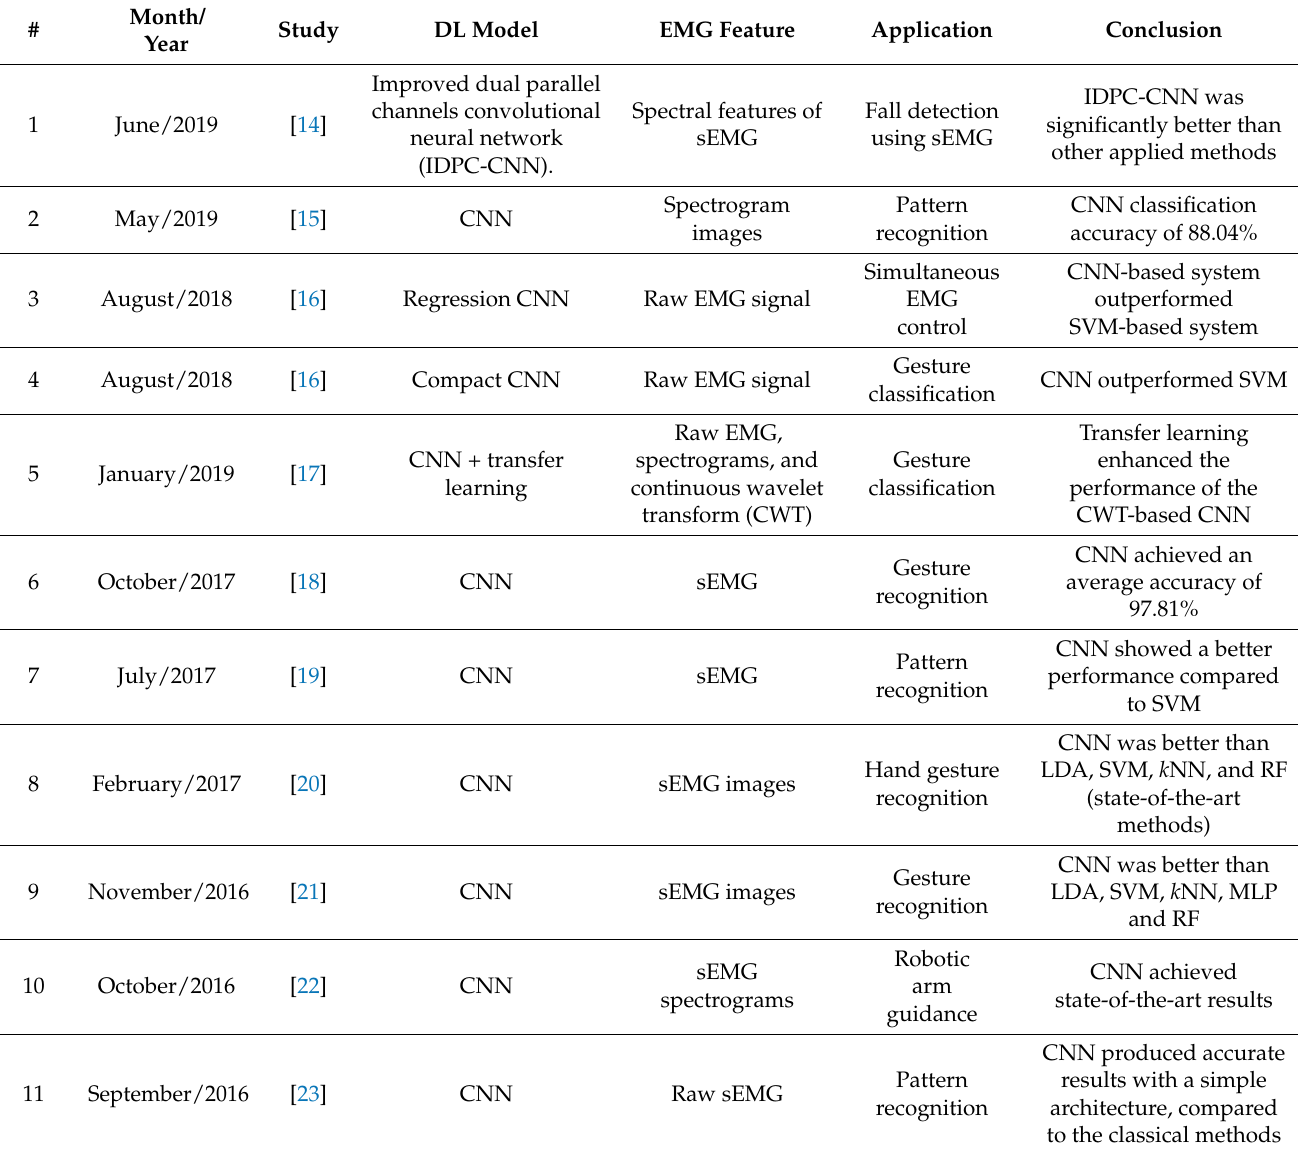
Table 1. Previous works related to EMG signals and deep learning